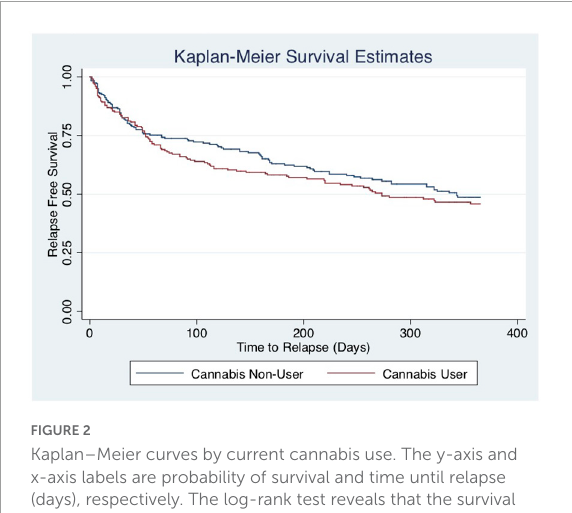
FIGURE2 Kaplan–Meier curves by current cannabis use. The y-axis and x-axis labels are probability of survival and time until relapse (days), respectively. The log-rank test reveals that the survival distribution between those who currently use cannabis and those who do not is not statistically different (chi-square: 0.77, p =